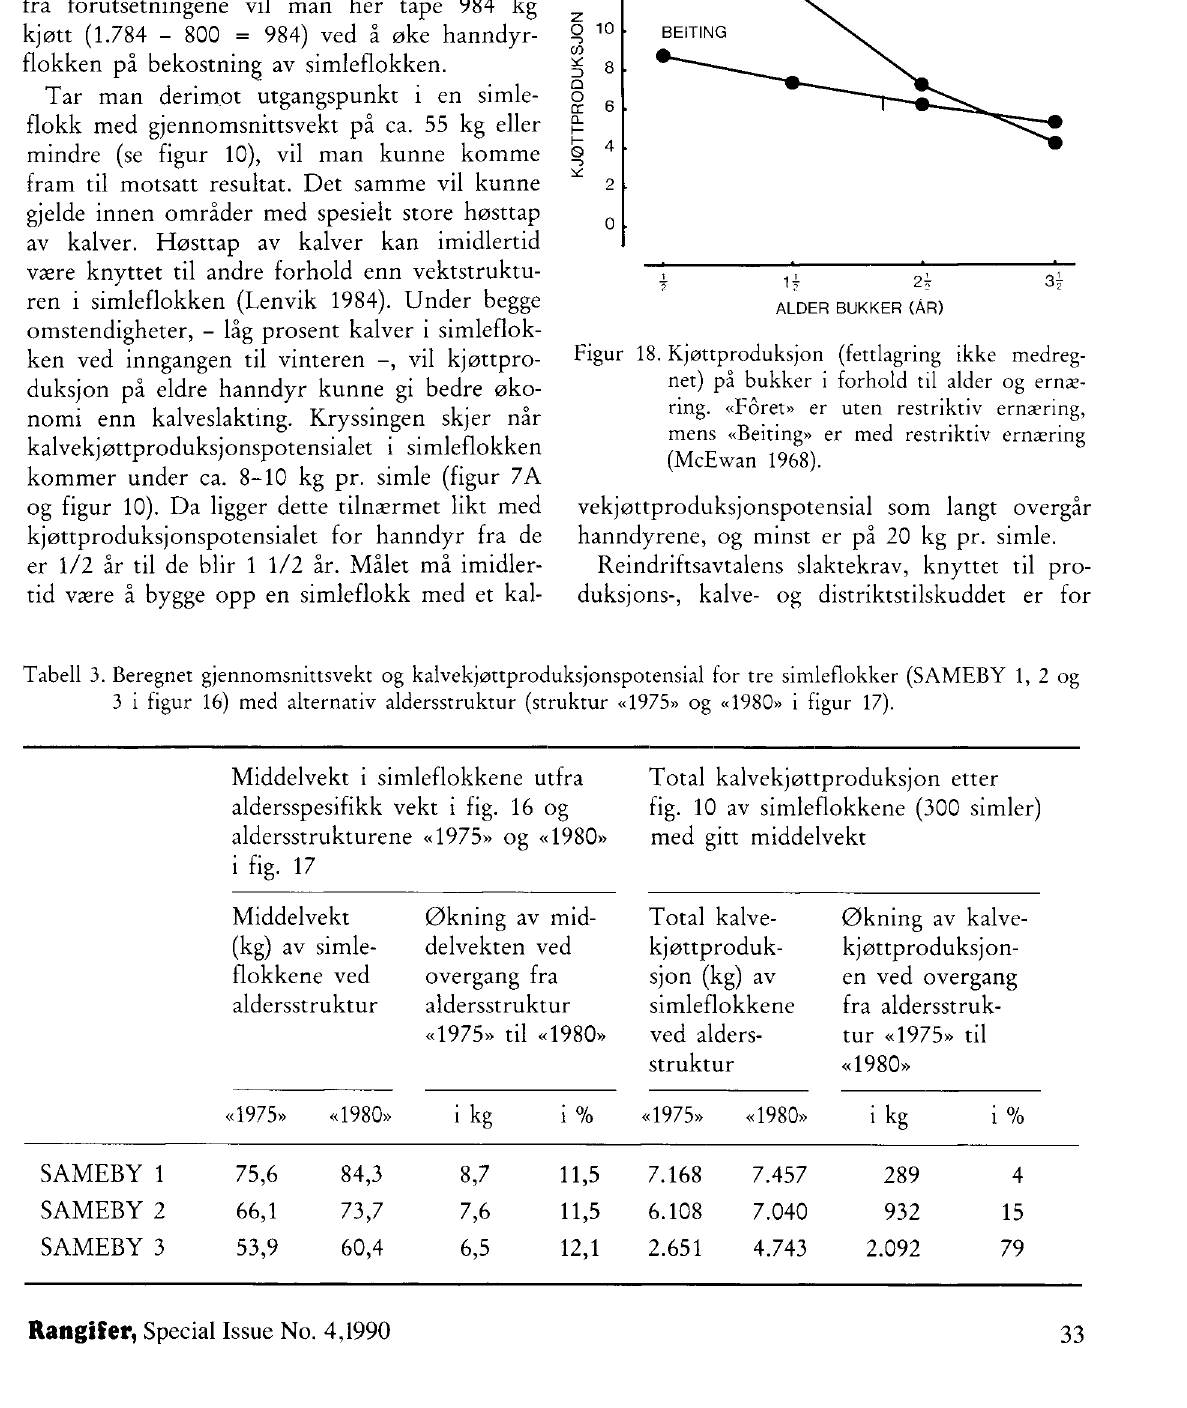
Middelvekt i simleflokkene utfra Total kalvekjøttproduksjon etter fig. 10 av simleflokkene (300 simler) med gitt